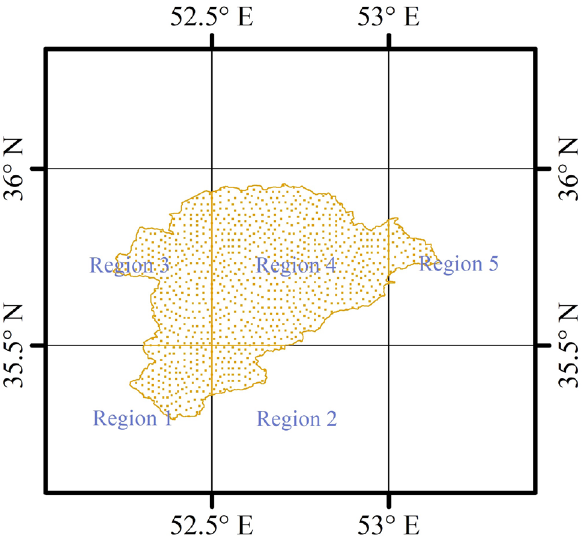
Fig.3 Division of the basin areas based on GCMs